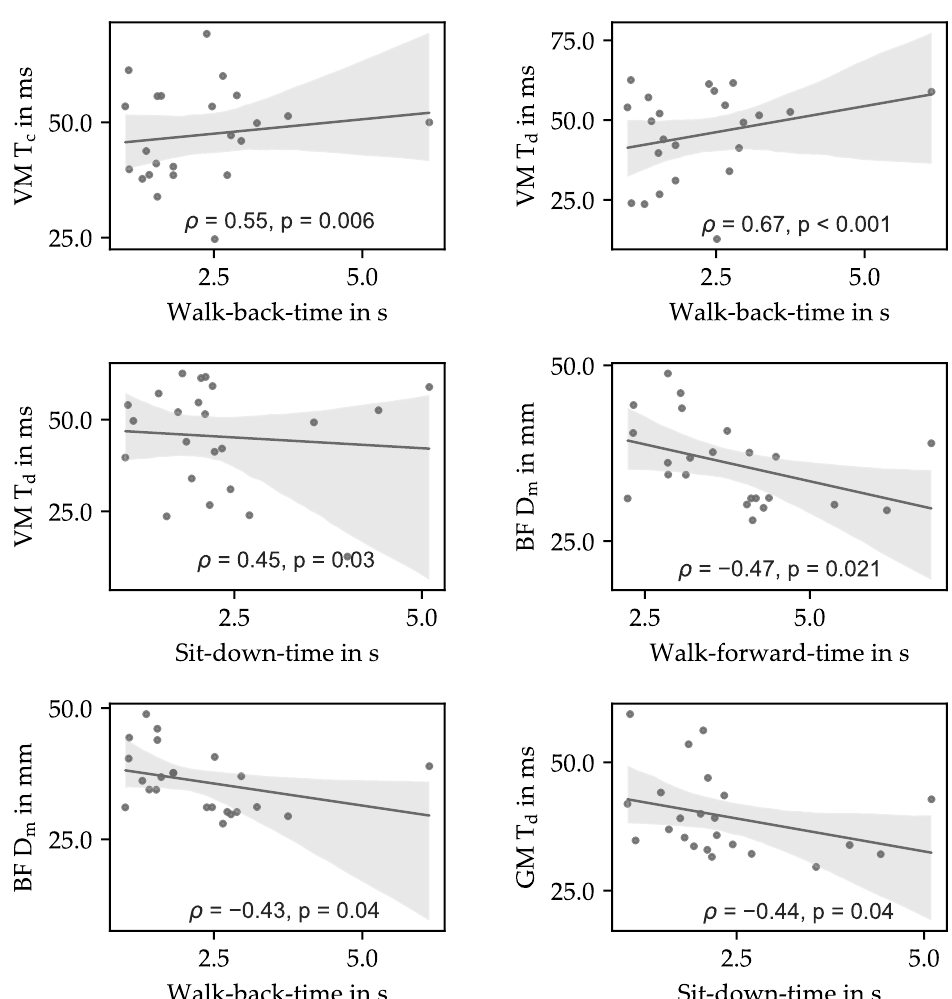
Figure 7. Scatter plots of significant correlations between vastus medialis ( VM ), biceps femoris ( BF ), gastrocnemius medialis ( GM ) tensiomyographic data, and TUG subtask